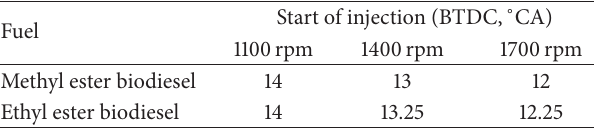
Table 3: Values of start of injection angle